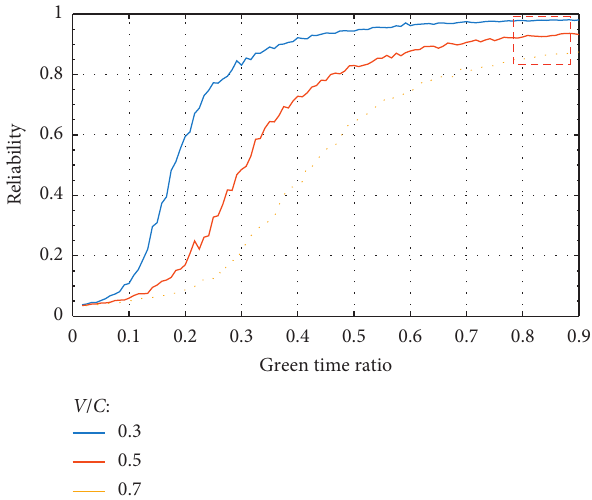
Figure 10: Traffic function reliability of actual intersection and in numerical example with a saturation of 0.9.